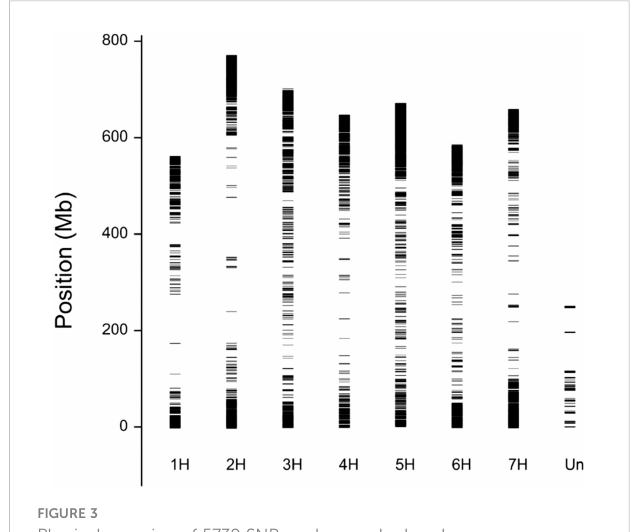
FIGURE 3 Physical mapping of 5739 SNP markers on barley chromosomes. Marker coverage is lower near the centromere and better further from the centromere, closer to telomere. The reason is not in the method, but in the fact that polymorphisms occur more often closer to the ends of the chromosomes than near to the centromere.